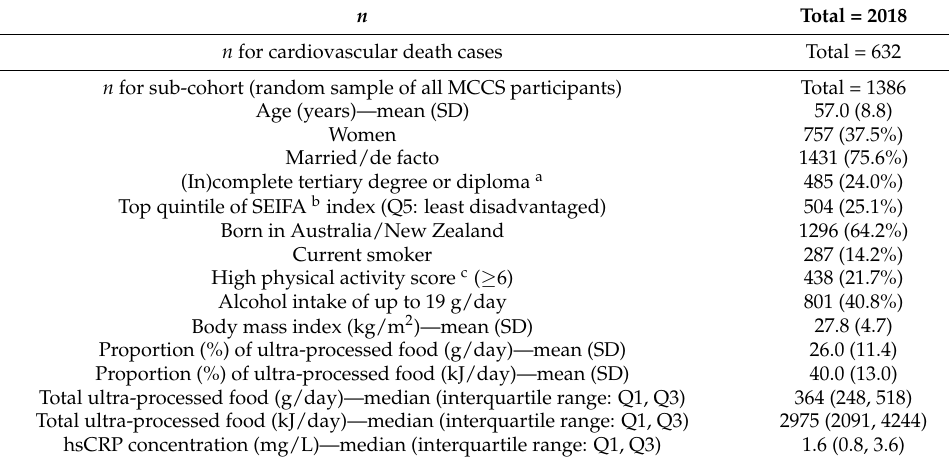
Table 1. Descriptive characteristics of the study